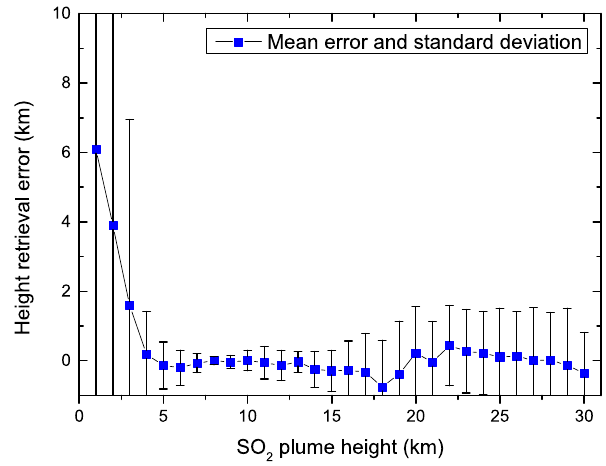
Fig. 2. Theoretical height retrieval error biases and standard devi- ations constructed from a simulation of 10000 IASI spectra with SO 2 altitudes between 1 and